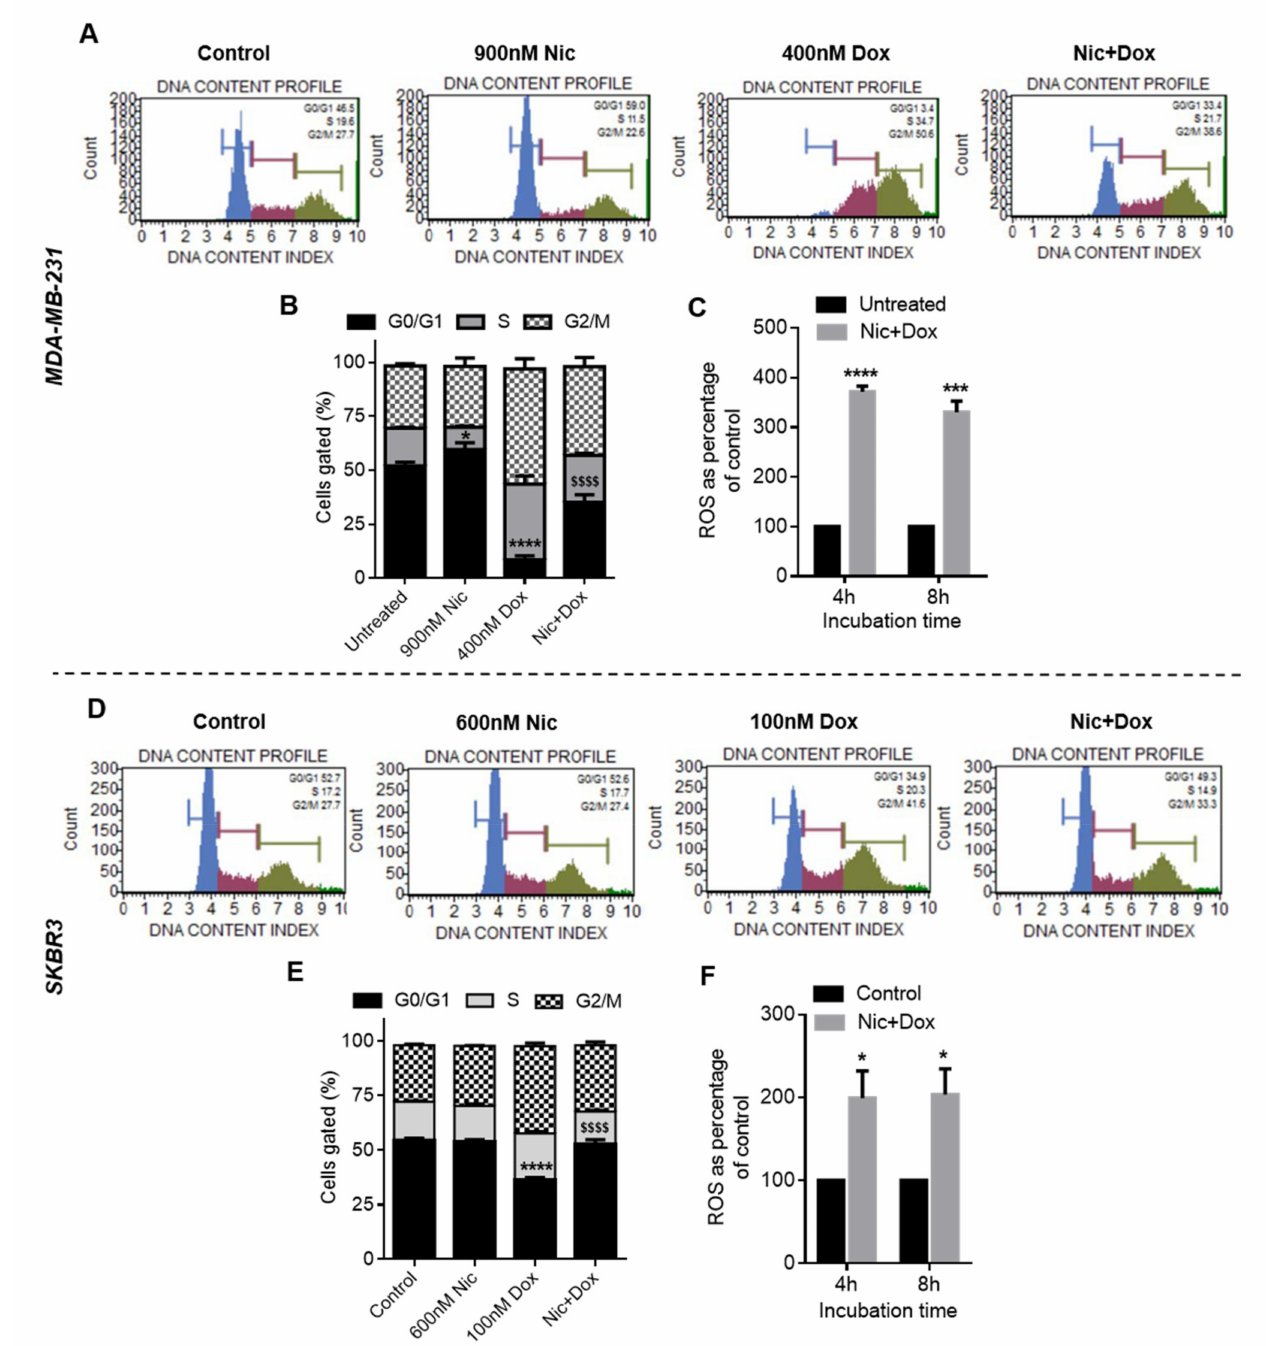
Figure 7. Cell cycle and ROS analysis in breast cancer cells after individual and concurrent treatment of Nic and Dox. Cell cycle histograms of ( A ) MDA-MB-231 and ( D ) SKBR3 cells, when treated with selected concentrations of Nic, Dox, and concurrent combination of Nic and Dox (Nic + Dox) for 24 h. Quantitative representation of cell cycle analysis for ( B ) MDA-MB-231 and ( E ) SKBR3. * ( p < 0.05) indicates statistically significant increase in G0/G1 phase of the Nic-treated group with respect to the untreated group; **** ( p < 0.0001) indicates a statistically significant decrease in the G0/G1 phase of the Dox-treated group with respect to all other groups and $$$$ ( p < 0.0001) indicates a statistically significant increase in the G0/G1 phase of the Nic + Dox-treated group with respect to the Dox group ( n = 3). Reactive oxygen species (ROS) analysis of Nic+Dox-treated cells at indicated doses for 4 h and 8 h through DCFDA assay in ( C ) MDA-MB-231, and ( F ) SKBR3 cells. * ( p < 0.05); *** ( p < 0.001), and **** ( p < 0.0001) indicate a statistically significant difference with respect to the untreated group ( n =